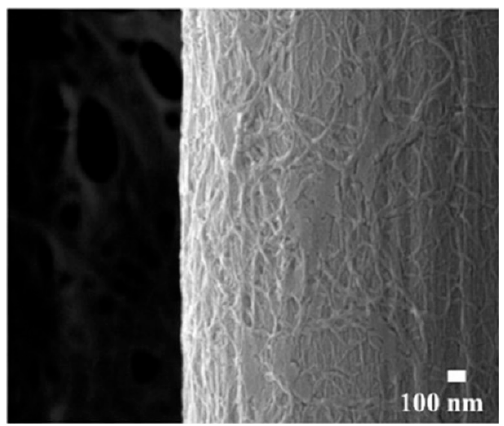
Figure 8. A network of aramid nanofibers (ANFs) grafted PPTA fibers [99]. Reprinted with permission from ref 99. Copyright 2019 Elsevier.